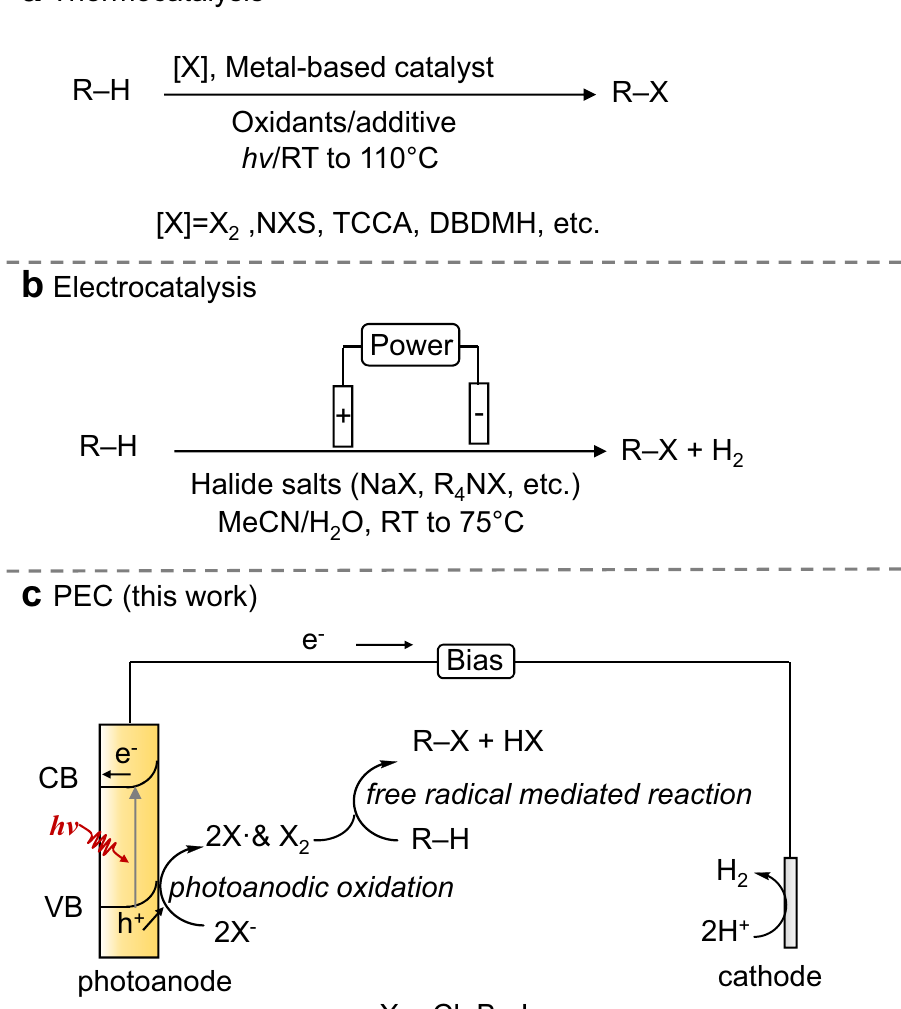
Fig. 2 C – H halogenation. a Thermocatalytic process. b Electrocatalytic process. c Photoelectrocatalytic process (this